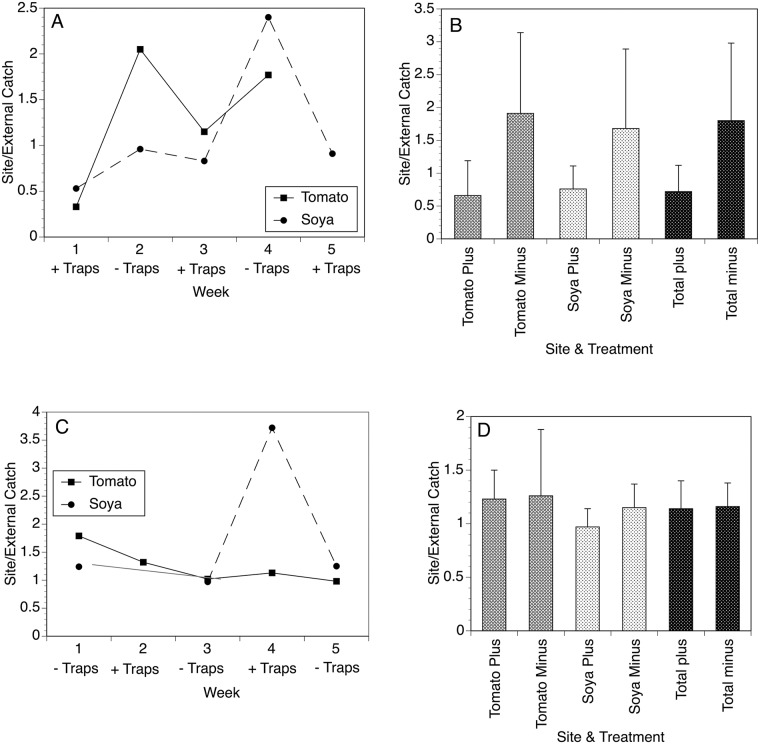
Effect of EWT trap deployment on biting rate in the fields of Gonycogo and Laminatoo.Panel A: Weekly fly collections in the tomato and soya fields of Gonycogo in the presence and absence of the traps. Traps were deployed and taken down in alternate weeks. Data are normalized to the number of flies collected by an external collector, to account for variations in the overall fly population. Panel B: Mean weekly collections in the tomato and soya fields of Gonycogo in the presence and absence of the traps. Error bars represent the standard deviations of the means. Panel C: Weekly fly collections in the tomato and soya fields of Laminatoo in the presence and absence of the traps. Traps were deployed and taken down in alternate weeks. Data are normalized to the number of flies collected by an external collector, to account for variations in the overall fly population. Panel D: Mean weekly collections in the tomato and soya fields of Laminatoo in the presence and absence of the traps. Error bars represent the standard deviations of the means. Raw collection data for this study may be found in the S6 Table.